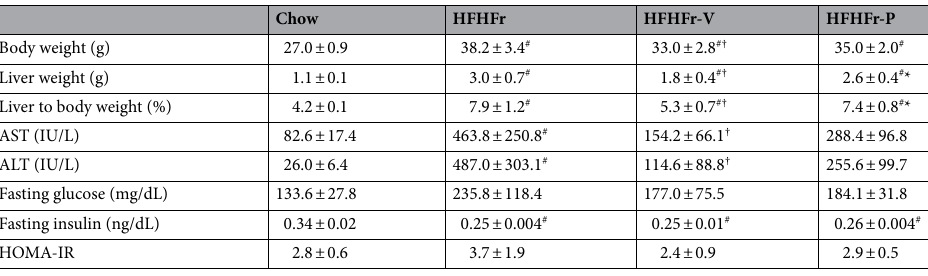
Table 1. Body weight and biochemical measurements at 20th week. HFHFr, high-fat, high-fructose diet group; HFHFr-V, HFHFr diet with voglibose group; HFHFr-P, HFHFr diet with pioglitazone group; AST, aspartate aminotransferase; ALT, alanine aminotransferase; HOMA-IR, homeostasis model assessment of insulin resistance. # P < 0.05 vs. chow, † P < 0.05 vs. HFHFr, * P < 0.05 vs.